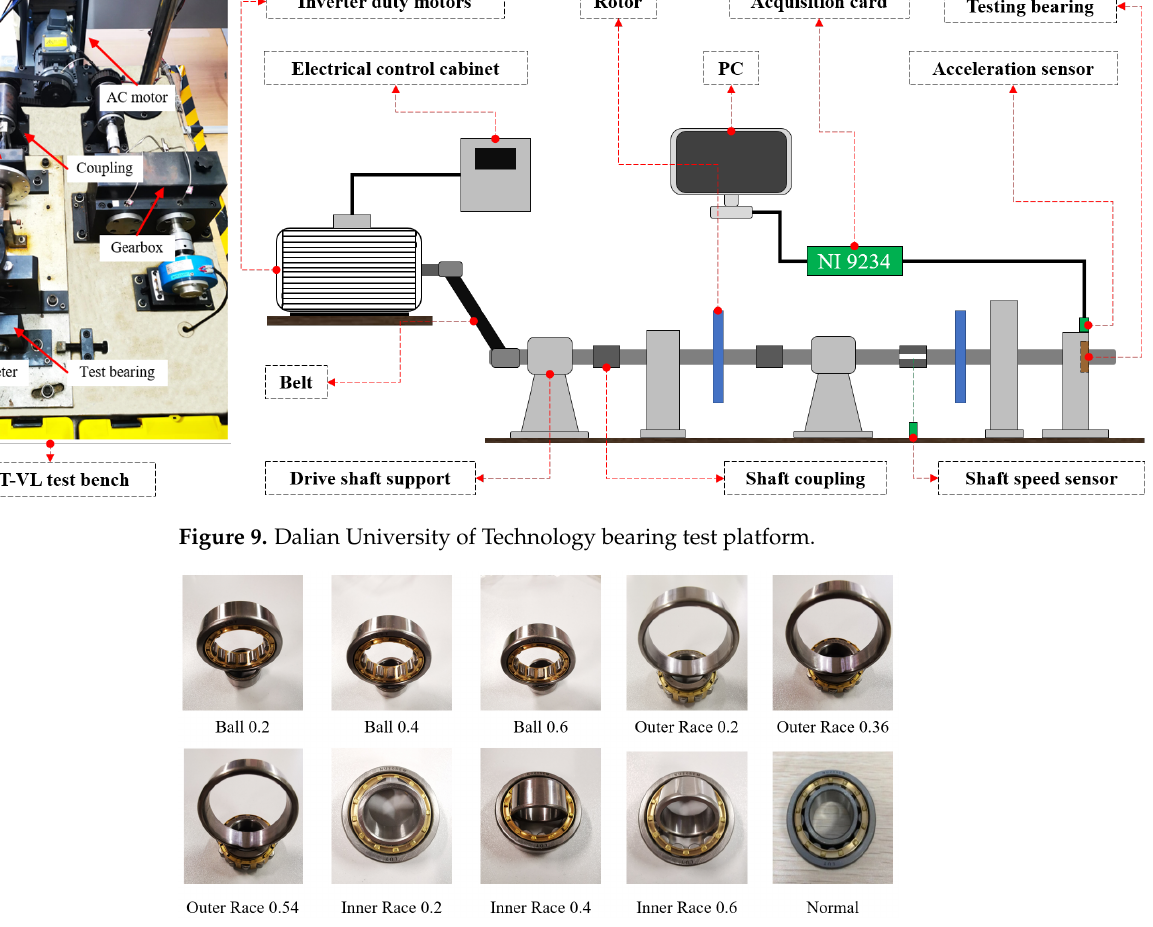
Figure 10. Fault types of bearings. Table 4. Bearing